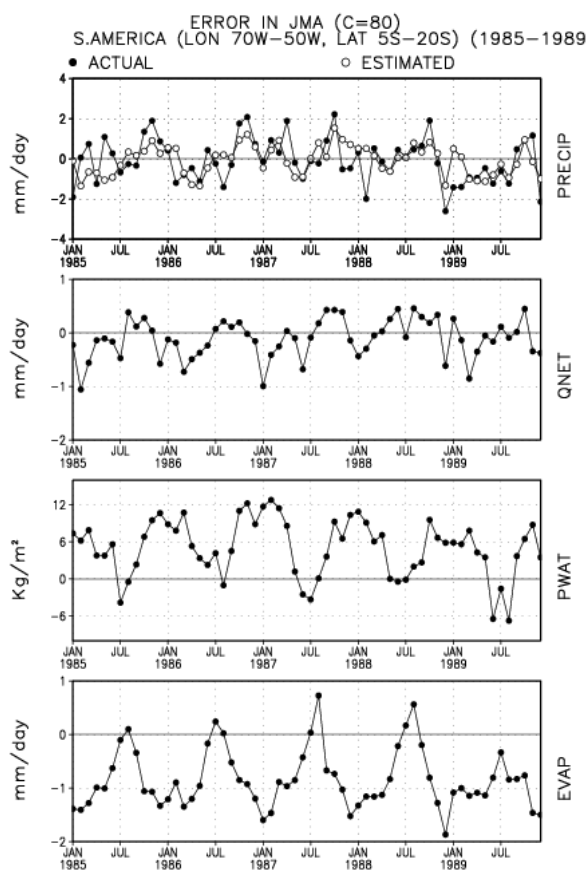
Fig. 11. Comparison between actual error in rainfall in JMA GCM and the error in rainfall estimated from the simple model in South America. Errors in Q net , P w and evaporation have also been